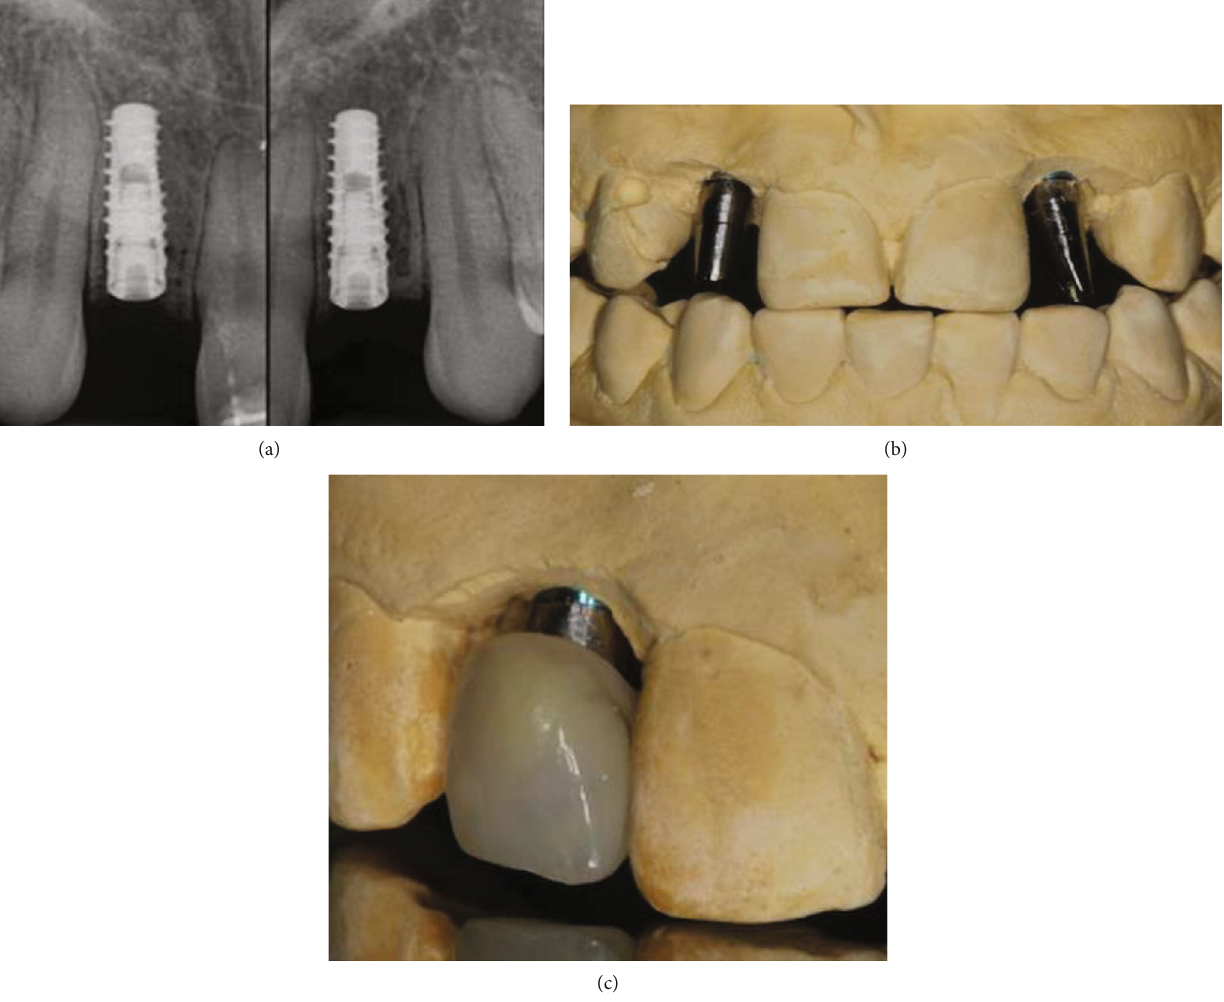
Figure 2: (a) Implants on lateral incisors positioned 4 months after placement. (b) The shoulderless abutments directly adjusted on the master cast. (c) The crown was placed 3 mm away from the analog (3 mm from the bone